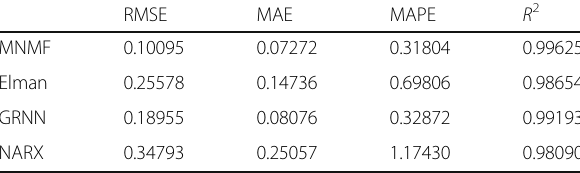
Table 8 Predictive evaluation of multiple models